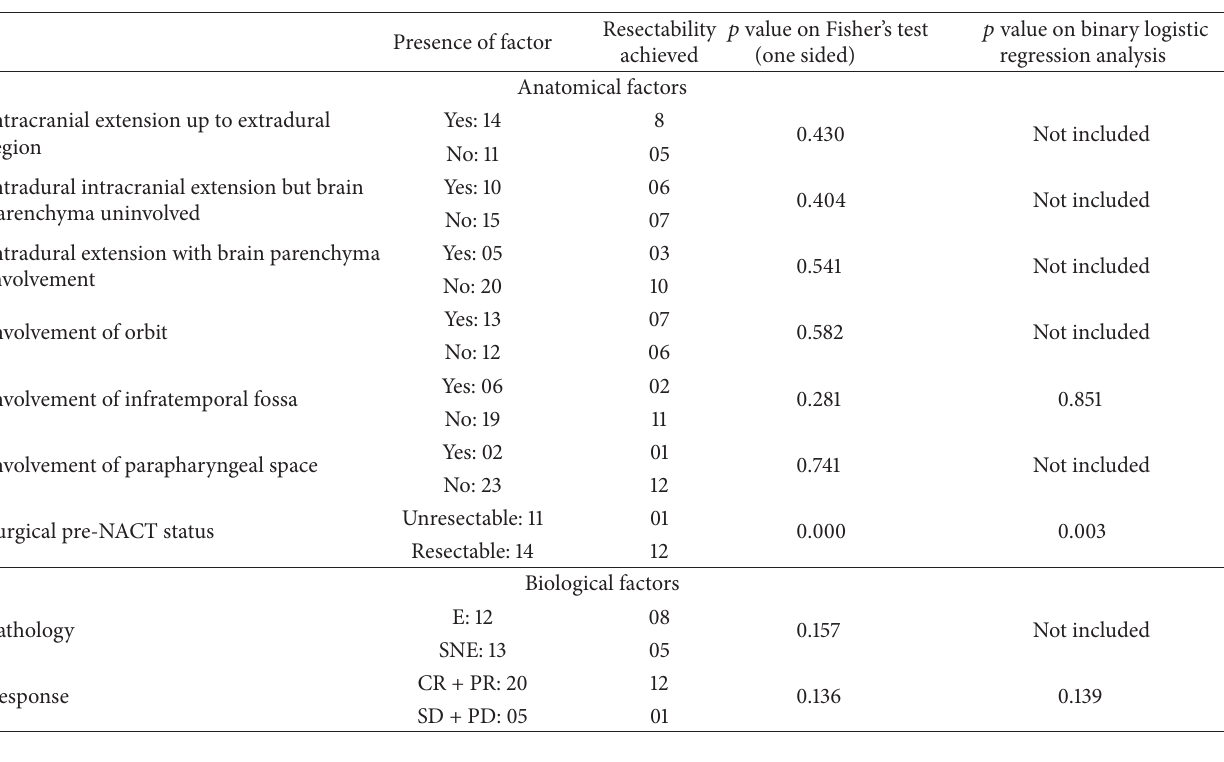
Table 5: Factors affecting achievement of resectability.